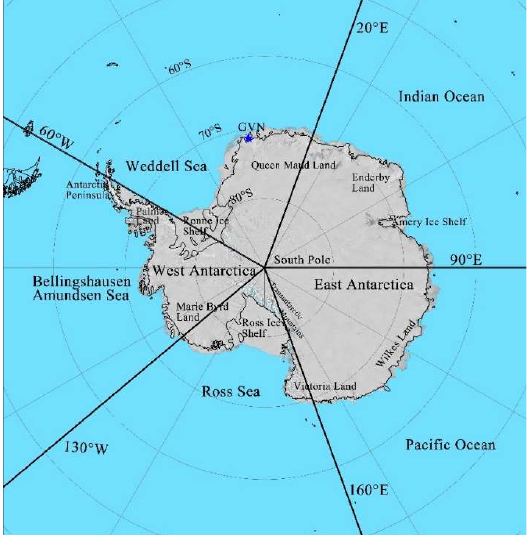
Figure 1. Map of the ASIR and the five longitudinal sectors. The thick black longitude line represents the boundaries of the five longitudinal sectors. The blue star in the map indicates the location of GVN station. (Modified from the Landsat Image Mosaic of Antarctica) [57].